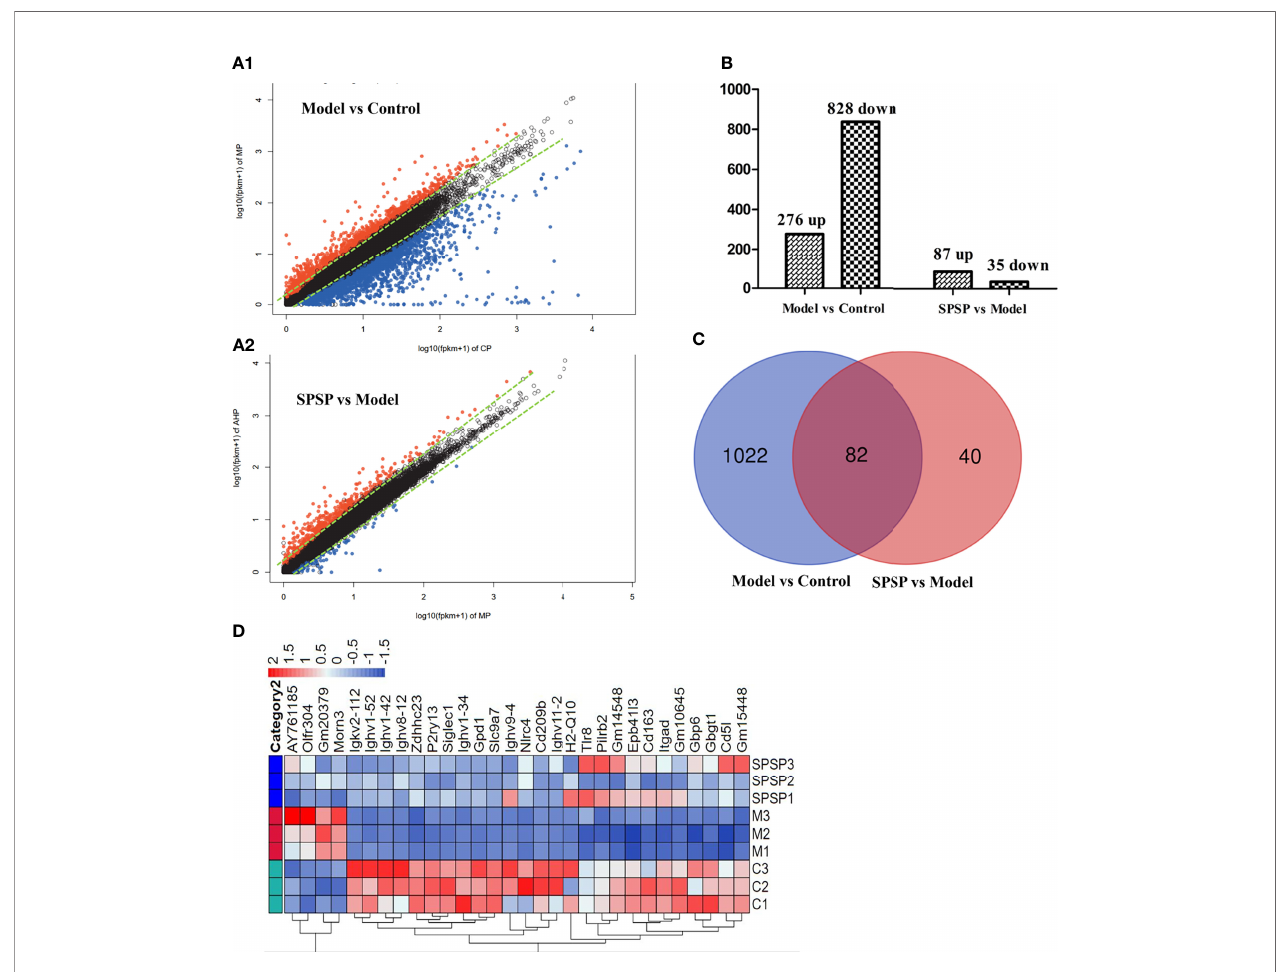
FIGURE 6 | General analysis of DEGs. (A1) Volcano plots of DEGs in model (M) vs control (C) group. (A2) Volcano plots of DEGs in SPSP vs model group. (B) Numbers of upregulated and downregulated DEGs. (C) Venn diagram of DEGs in M vs C and SPSP vs M comparisons. (D) Hierarchical clustering of overlapped